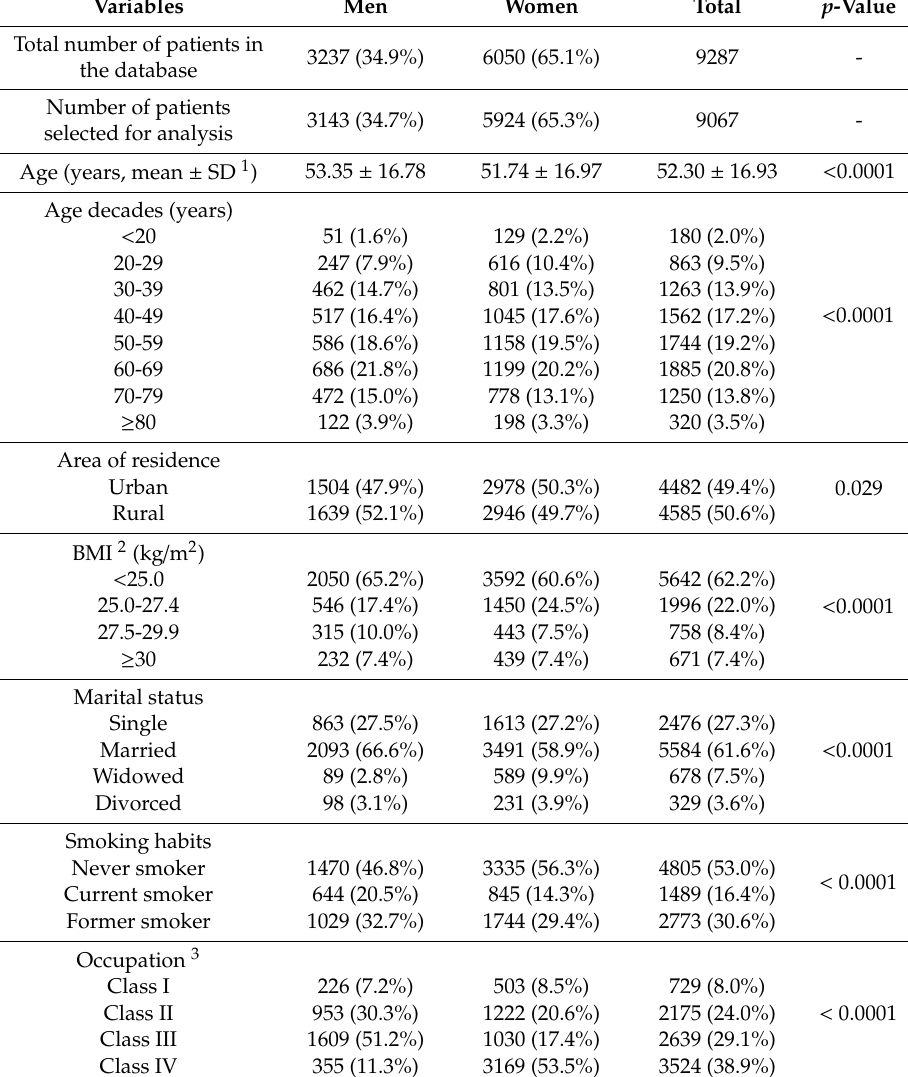
Table 1. Demographic and anthropometric features of the study participants.